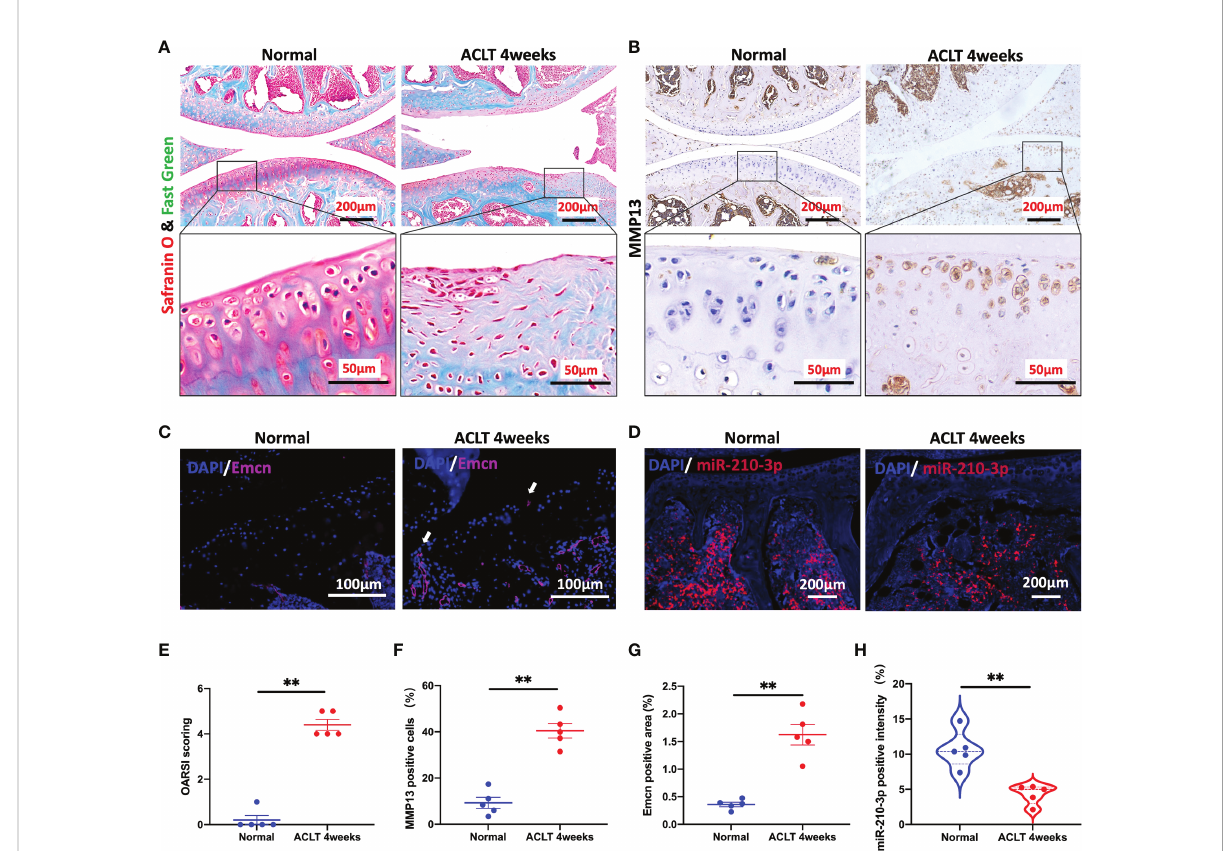
FIGURE 1 miR-210-3p expression is negatively related to aberrant subchondral angiogenesis in OA. Ten-week-old C57BL/6 mice underwent ACLT. Knee joints were harvested at 4 weeks after surgery. n = 5 mice per group. (A) Safranin O – fast green staining for the knee joint (sagittal view). Scale bar: 200 m m (top), 50 m m (bottom). (B) Immunohistochemical staining for MMP13 in the joint (top) and cartilage (bottom) of normal mice and ACLT for 4 weeks mice. Scale bar: 200 m m (top), 50 m m (bottom). (C) Immuno fl uorescence staining for Emcn (red) and DAPI (blue) in the subchondral bone of tibia. Vessels invading the cartilage are indicated by white arrows. Scale bars: 100 m m. (D) ISH staining for miR-210-3p (red) and DAPI (blue) in the subchondral bone of tibia. Scale bars: 200 m m. (E) Calculation of OARSI scores. (F) Quanti fi cation of the number of MMP13-positive cells in cartilage. (G) Quanti fi cation of the positive area of Emcn staining. (H) Quanti fi cation of the intensity of miR-210-3p staining in subchondral bone. ** P < 0.01. All data are presented as the means ± standard deviations. Statistical signi fi cance was determined using unpaired, 2-tailed Student ’ s t